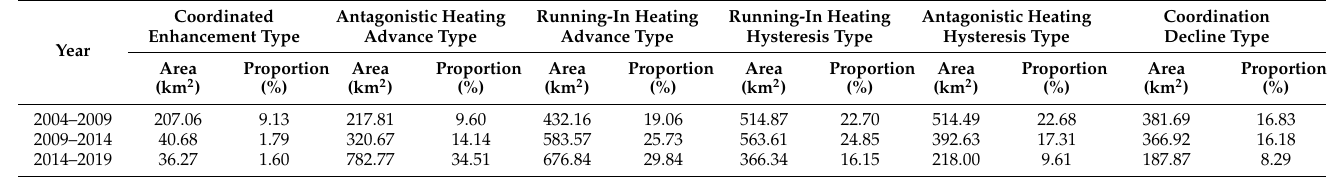
Table 6. Areas and proportions of coordination types between NTL and LST within the sixth ring road of Beijing from 2004 to 2019.